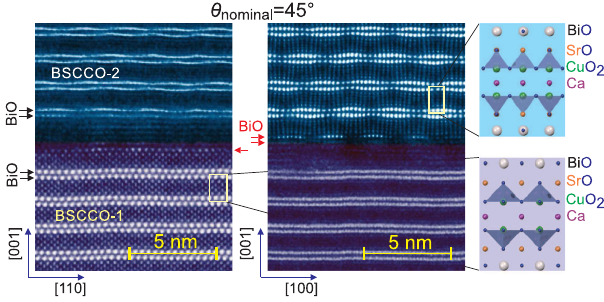
FIG. 3. Atomically resolved TEM images around the BSCCO- 1 – BSCCO-2 interface. Arrows mark the BiO layers. Right-hand panels illustrate the atomic structure of 0.5 UC BSCCO viewed 1¯10 from [010] (upper) and [ ] (lower) directions,